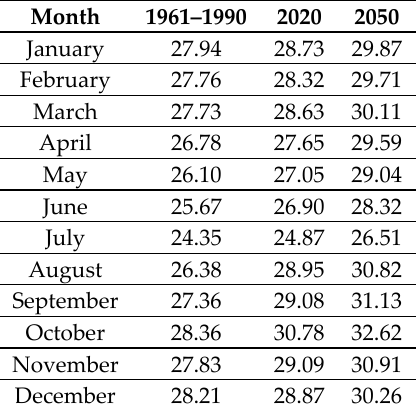
Table 4. Monthly soil temperature for the base Scenario (1961–1990) and future